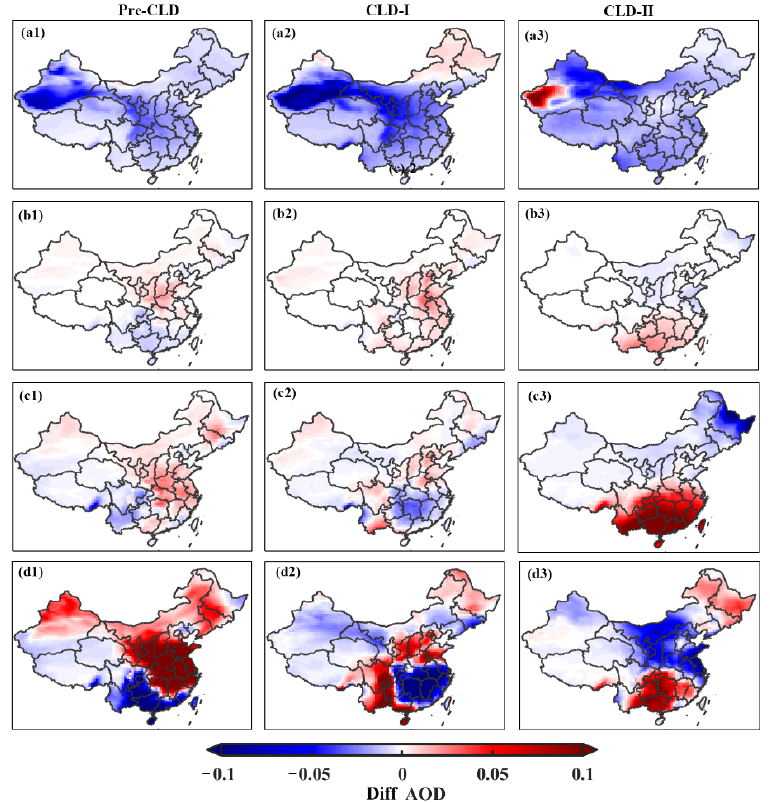
Figure 6. Difference (AOD) of the three absorbing aerosols (dust ( a1 – a3 ), BC ( b1 – b3 ), and OC ( c1 – c3 )) and scattering aerosol (SO 4 ( d1 – d3 )) during the Pre-CLD, CLD-I, and CLD-II periods, with the mean values of the same window in previous years (2017–2019). The study area’s boundaries and the locations of key cities were shown in Figure 1.